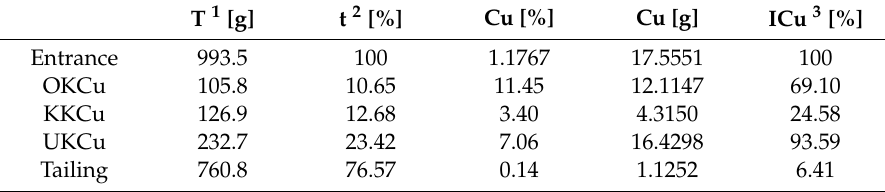
Table 12. Floating power by applying liquid Na-iPrX (produced by an innovative